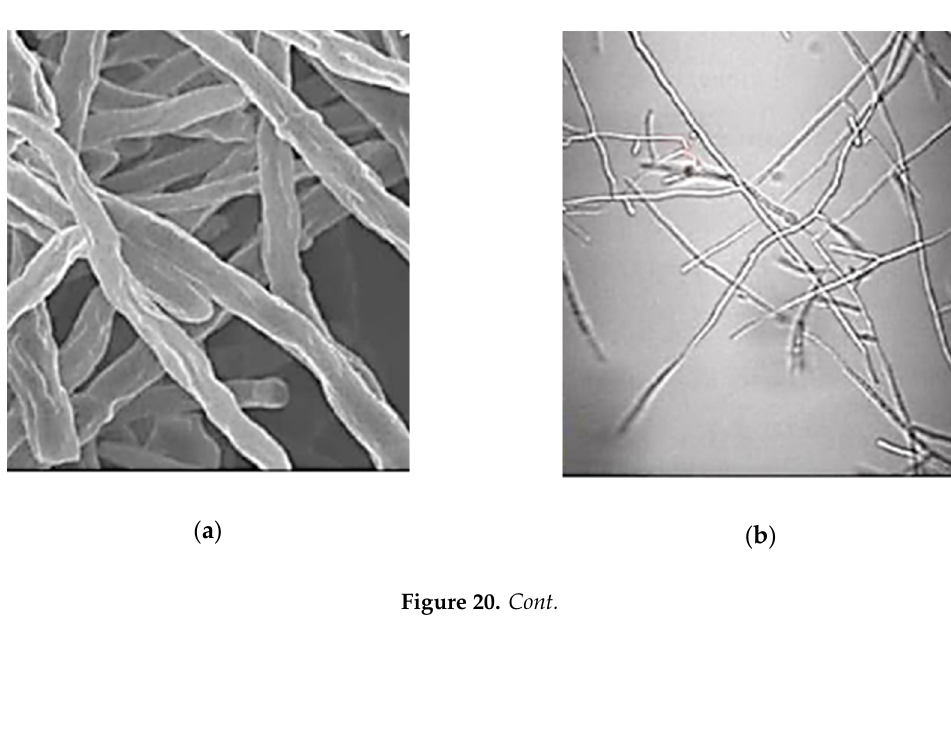
Figure 19. Structure of chitosan pristine bionanomolecules.